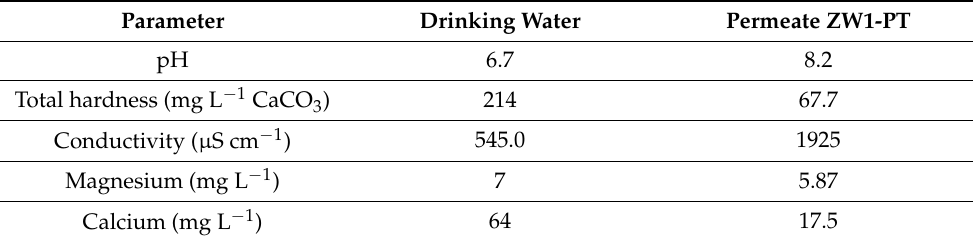
Table 4. Comparison of drinking water (Galeb d.d.) with ZW1-Pt effluent for washing dyeing